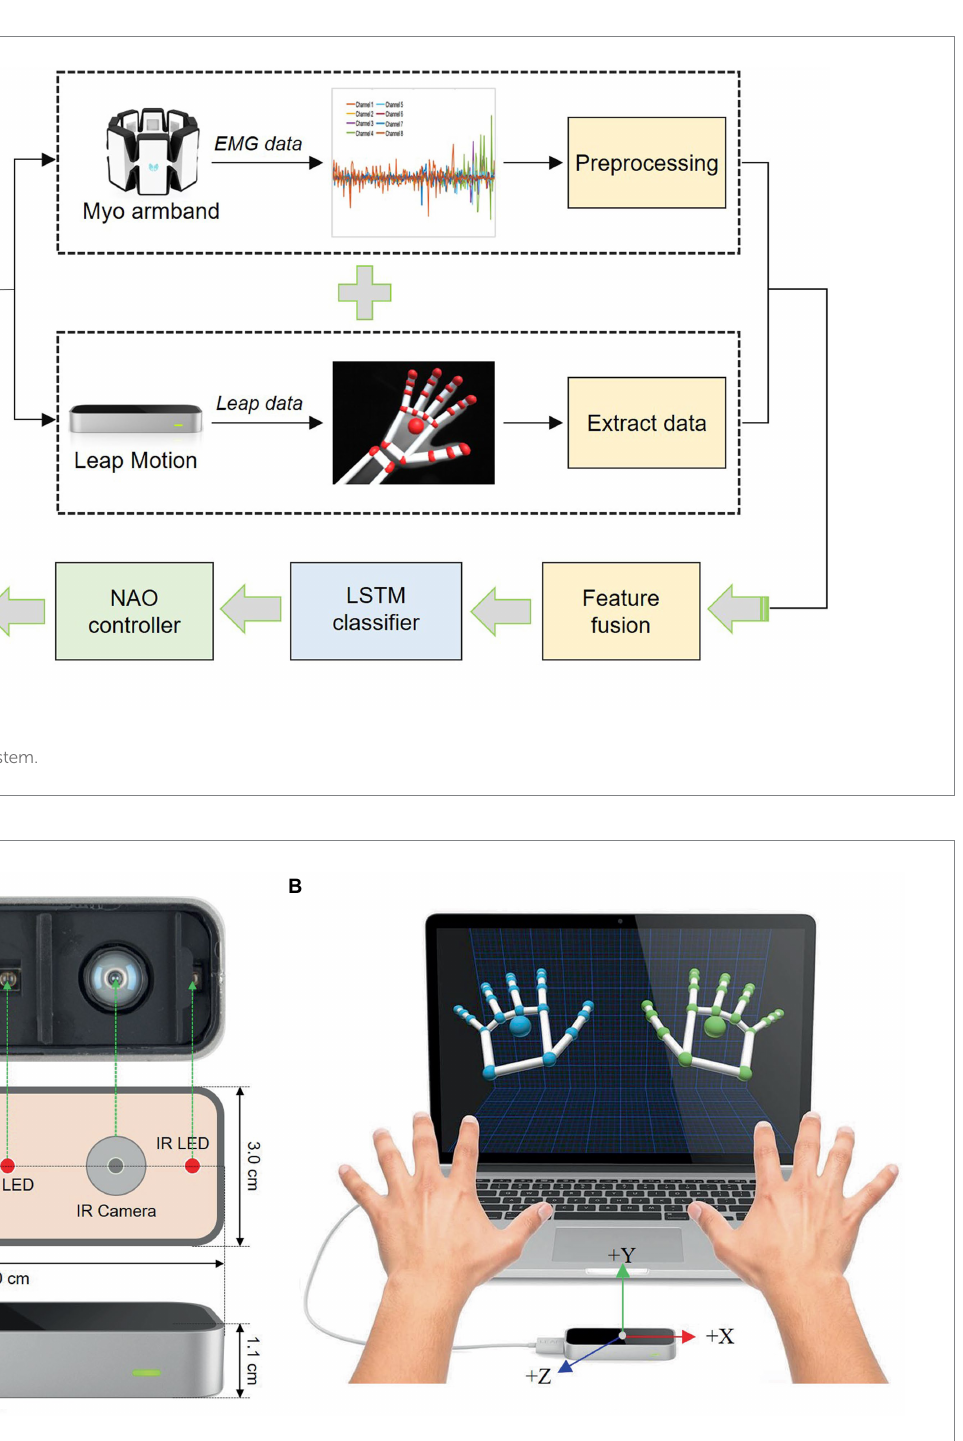
Figure 4 demonstrates the fingertips, wrist, and palm position. For each performed gesture, we record all the 3D coordinates of human hand. Then, the start palm position, the difference between the start palm positions, changes of palm positions, palm direction, and velocity of the palm are extracted from these 3D coordinates. As shown in Figure 4, we also extracted the yaw, pitch, and roll of the palms. It is noted that yaw is the angle between the negative z -axis